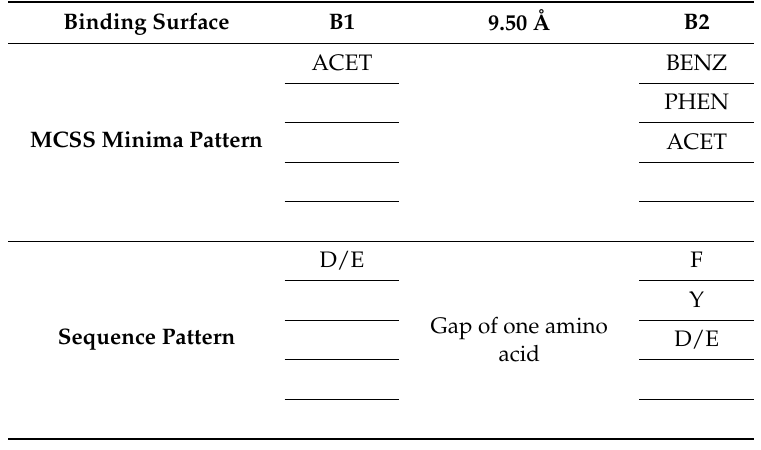
Figure 8. Selected MCSS minima of functional groups on the surface of antibody BH151. ( A ) BENZ; ( B ) PHEN; ( C ) ACET. Figures were prepared using PyMOL [24]. Table 5. Distribution of key minima and the derived sequence pattern for the binding epitope peptides to the antibody BH151. A sequence pattern of “X-J”(X = D/E, and J = F, Y,D/E) was